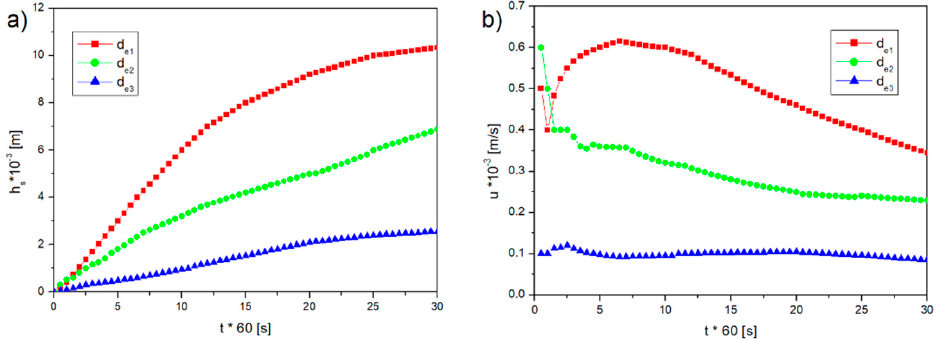
Figure 11. Plot of ( a ) sediment layer height and ( b ) sedimentation velocity versus process time for sedimentation of 0.3 g/mL microspheres in the size range 300–400 μ m in a 70% emulsion for different oil droplet diameters.